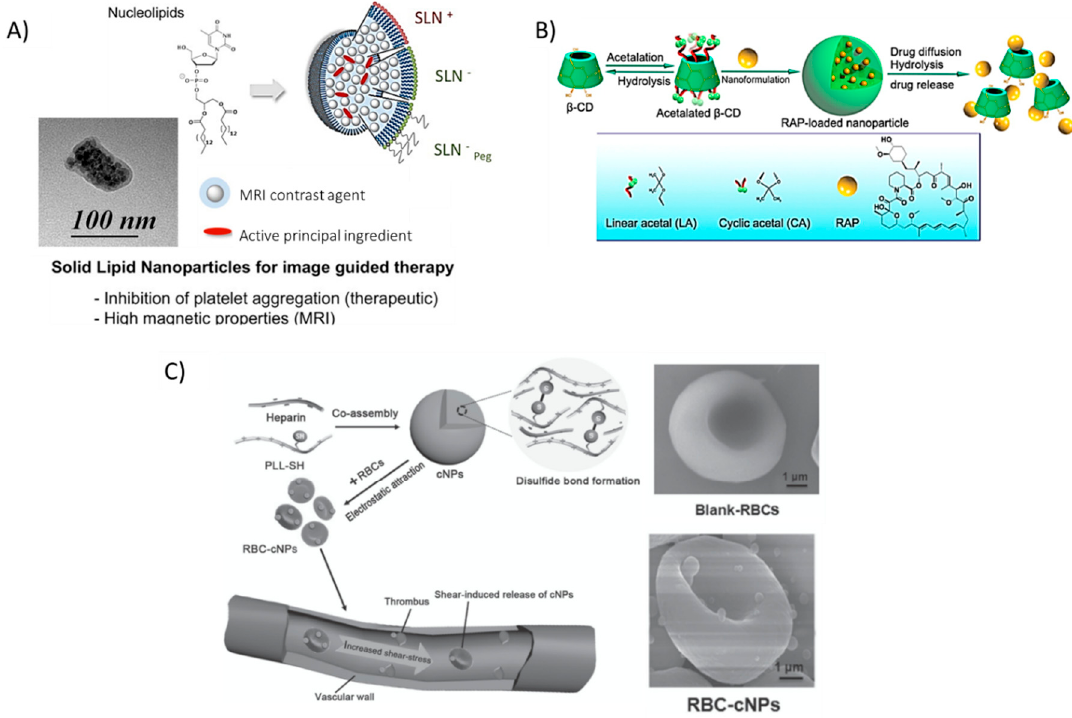
Figure 6. Recent nanoparticle formulations enhancing drug delivery properties in atherosclerosis.